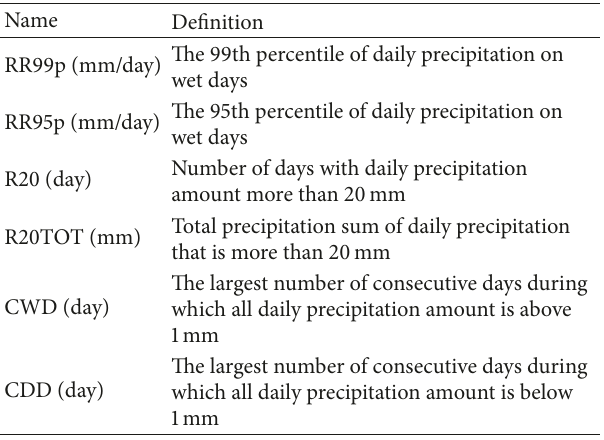
Table 5: The precipitation indices used in this